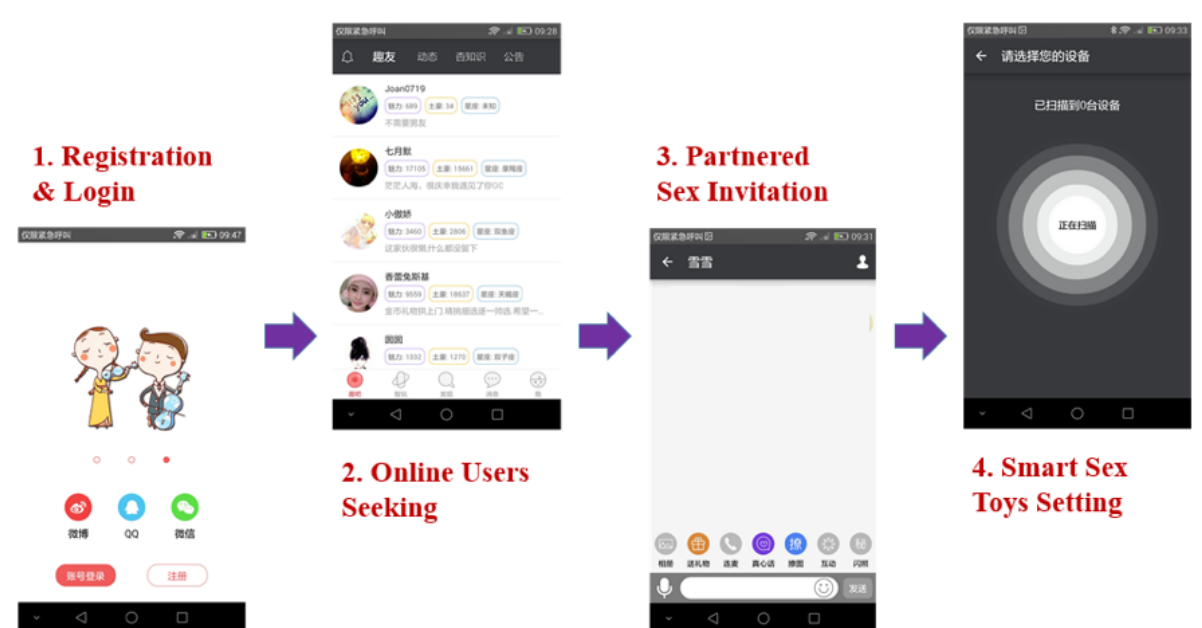
Figure 3. Basic usage process of sexual behavior acquisition system (SeBA).